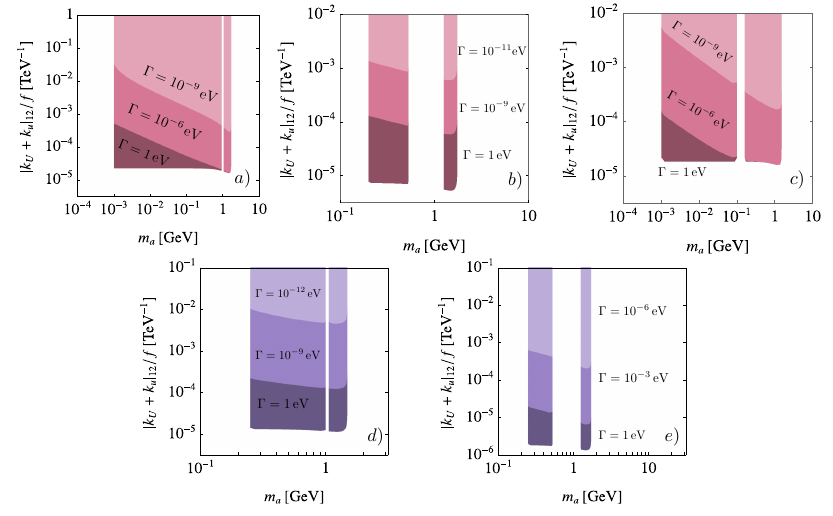
Figure 10 . Constraints on the flavor-violating ALP couplings [ k u ] 12 and [ k U ] 12 from D meson decays, collected in table 1, for different values of the total ALP width. The color-coding indicates the final state: red for a → e + e − decays and purple for a → µ − µ +